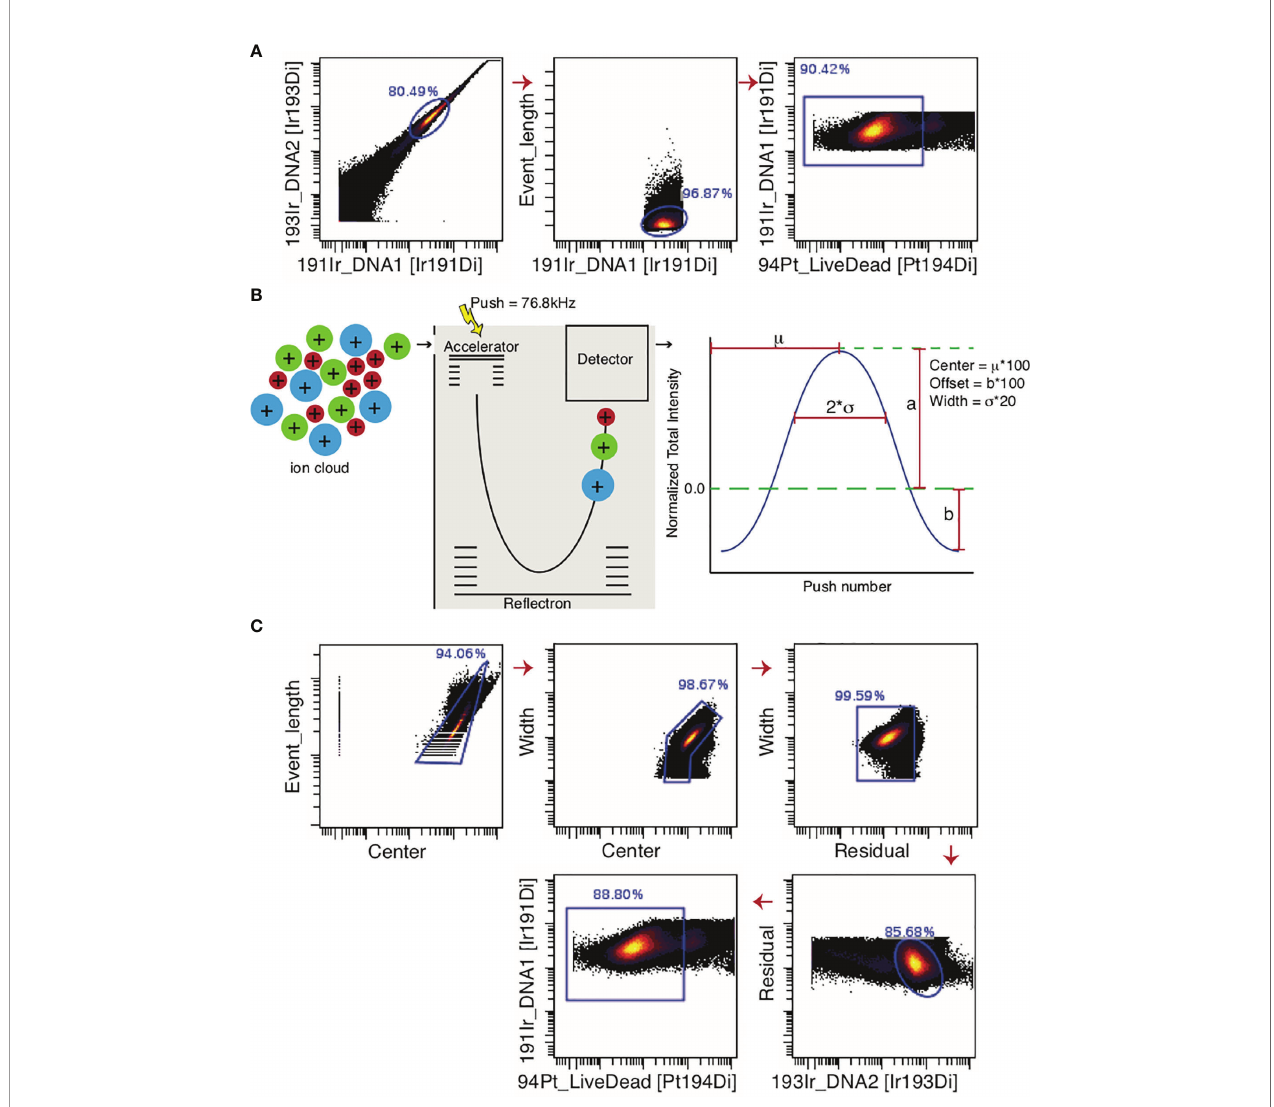
FIGURE 5 | Gating strategies for live single cell events. (A) For data generated by the CyTOF2 ® machine, the predecessor of Helios ® , single cells were gated only on the bases of Event Length and the DNA intercalator. Live cells are selected as cisplatin-negative events. (B) In the Helios ® machine, the Gaussian parameters are generated in the Time-Of-Flight chamber where ions are separated on mass-to-charge ratio. Once these ions encounter the detector, an electronic pulse is generated, which is mathematically smoothened into a bell curve. Center, Offset, and Width can be extracted from this curve. (C) The added Gaussian parameters greatly improve the ability to select a single-cell population. Note that if beads are not excluded through the normalization process, they must be gated out manually before gating for single live